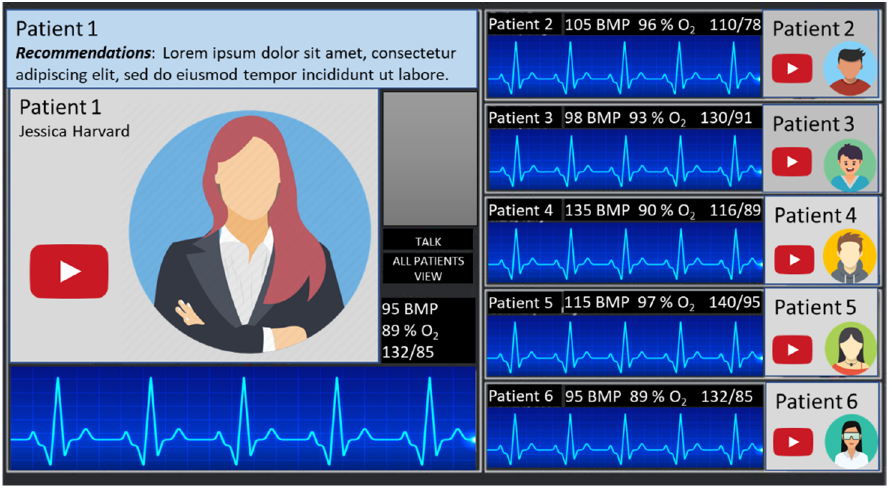
Figure 8. Demo design for physician HMI that focuses on a single patient. Privacy and data integrity of the patients: Data integrity and patient confidentiality